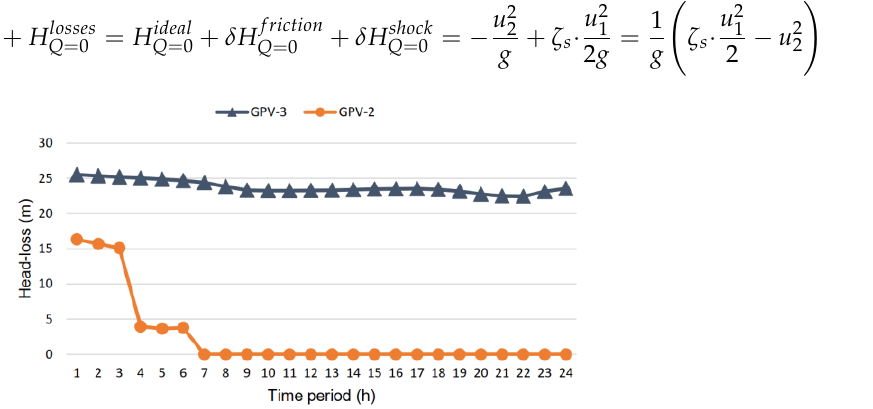
Figure 10 . GPV-2 and GPV-3 head loss requirements during their active time periods . Figure 10. GPV-2 and GPV-3 head loss requirements during their active time periods.